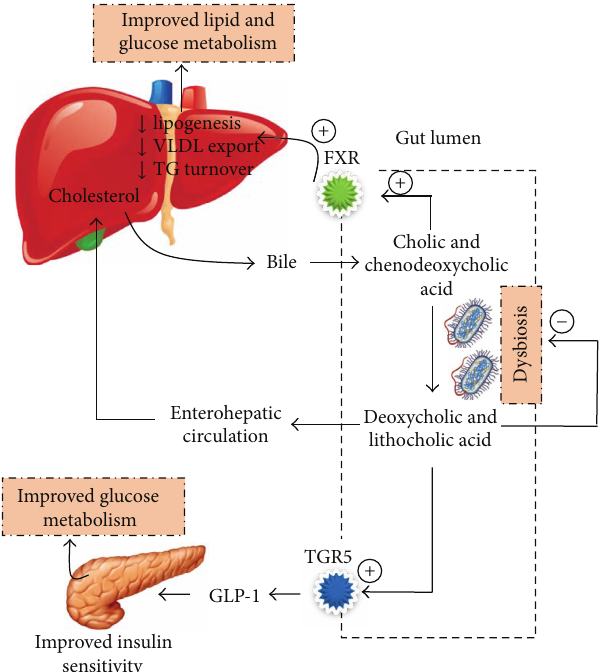
Figure 1: Modulation of bile acid circulation by gut microbiota and its effect on glucose metabolism. Concept adapted from [6– 8]. TGR5: G protein coupled receptor 5, VLDL: very low density lipoprotein, TG: triglycerides, GLP-1: glucagon like peptide-1, and FXR: farnesoid x